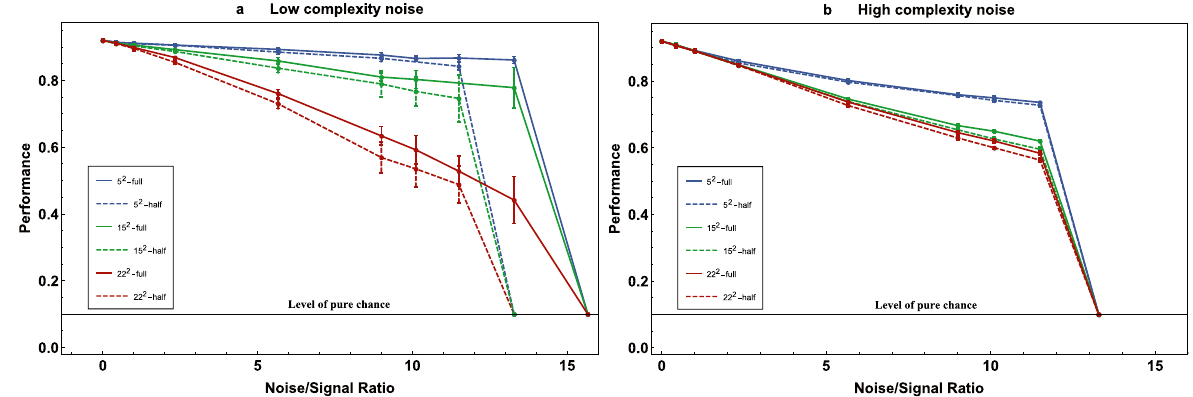
Figure 3. The test accuracy, i.e., the performance of the network on the test dataset, as a function of the noise- to-signal ratio. Notice that, since there are 10 different fashion items, a success rate of 10% indicates that the network classifies at a rate that is equal to pure